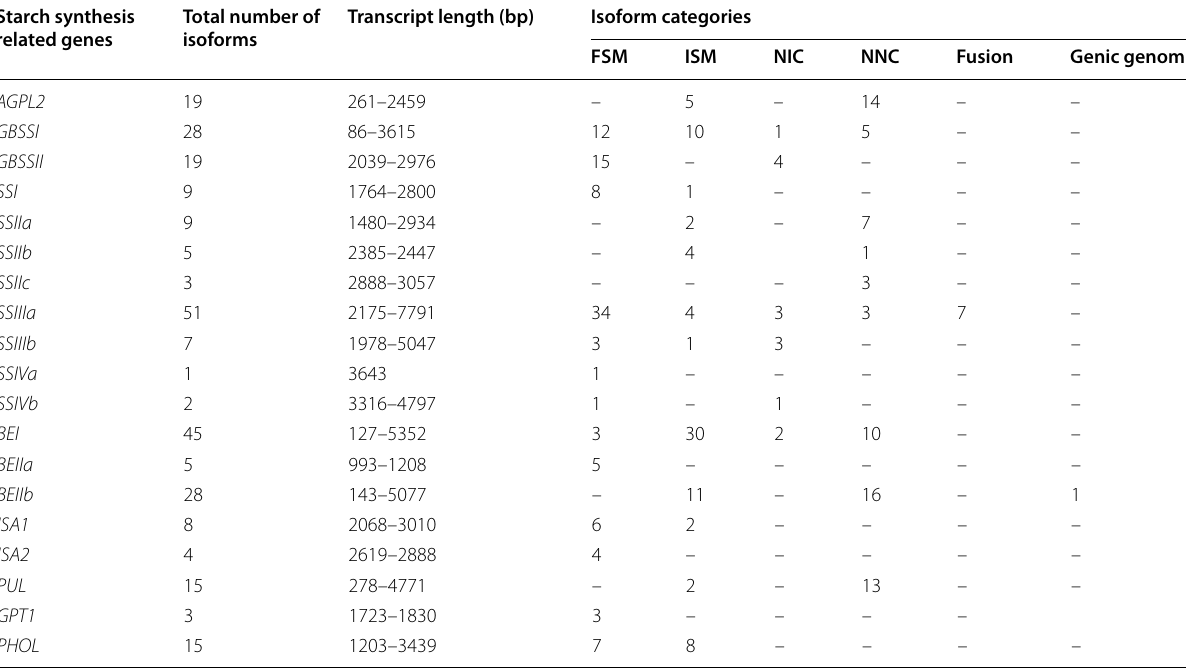
Table 2 Distribution of isoforms with length (in bp) in 19 starch synthesis related genes